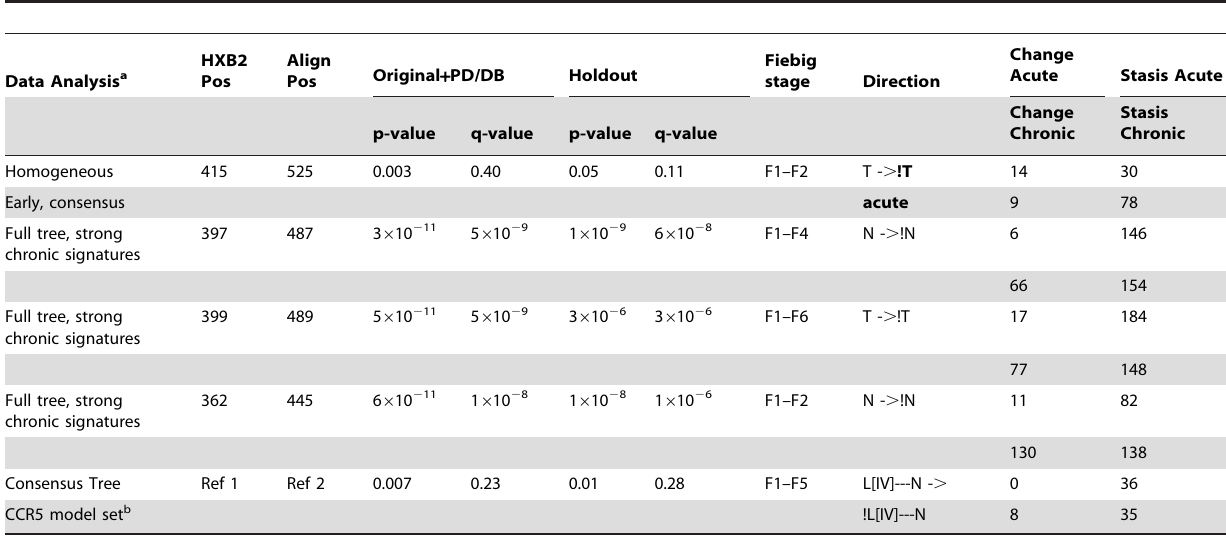
Table 3 . Summary statistics additional signatures identified with additional searches, using the combined original and PD/DB sets to identify potential signatures and comparing to the holdout set. For legend see table